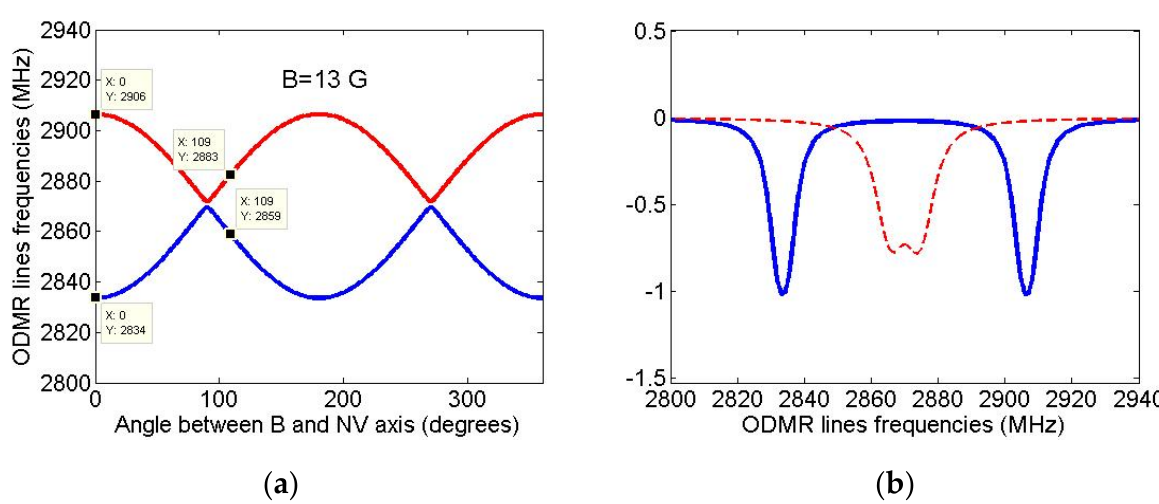
Figure 6. ( a ) Simulated dependence of ODMR line frequencies ω + and ω − corresponding to the transitions m S = +1 → m S = 0 (red curve) and m S = − 1 → m S = 0 (blue curve) on the polar angle θ , which determines the direction of the field B = 13 G relative to the center axis. It follows from the Figure 6a that the first NV center is aligned along the applied field, while the second one makes an angle of ~109 ◦ with this field. ( b ) Simulated ODMR spectra of the two NV centers studied in [31]. The solid blue curve corresponds to the NV center in the magnetic field B = 13 G being parallel to the axis of this center, the dashed red one—to the second NV center aligned at an angle of 109 ◦ to the applied magnetic field B = 4.7 G.